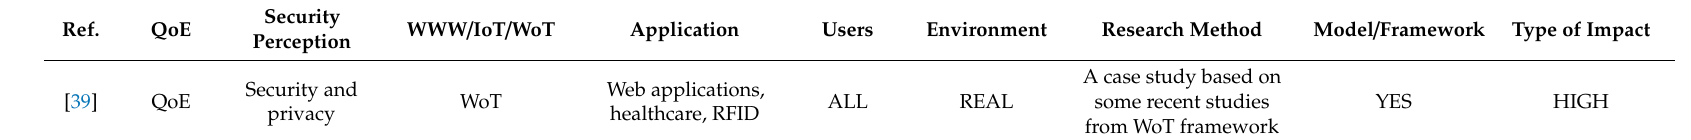
Table A2. The influence of perceived security on QoE.